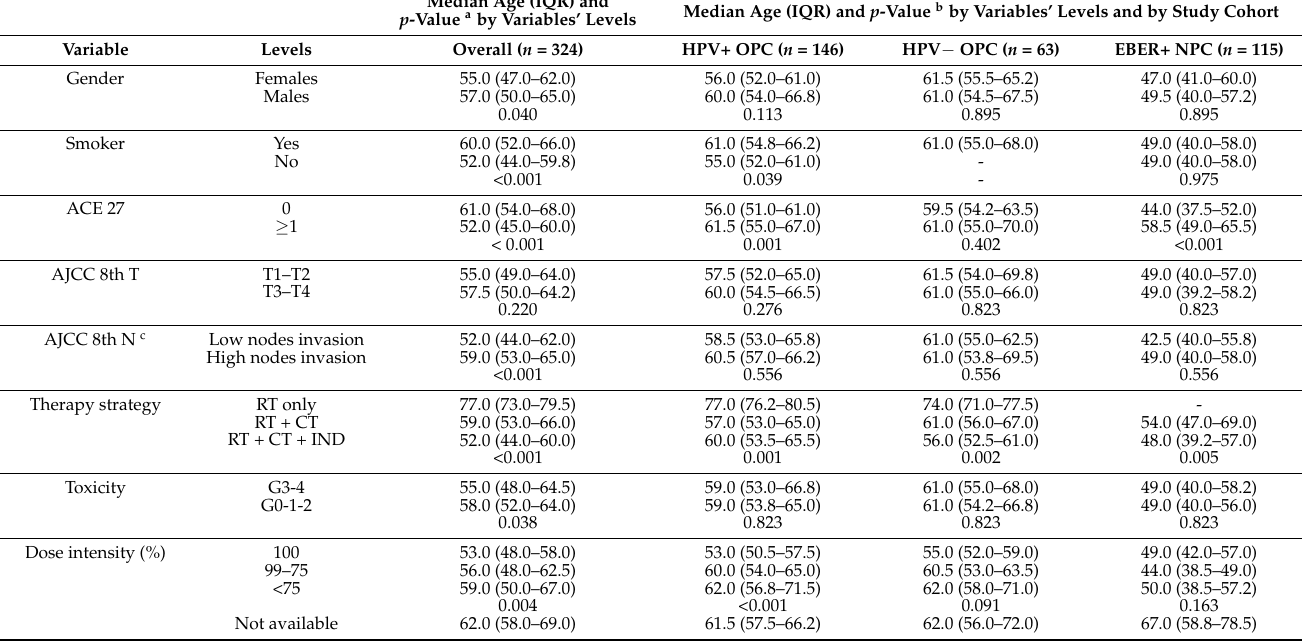
Table 2. Median age and interquartile range in the overall sample and in the study cohorts by patients’ and treatment